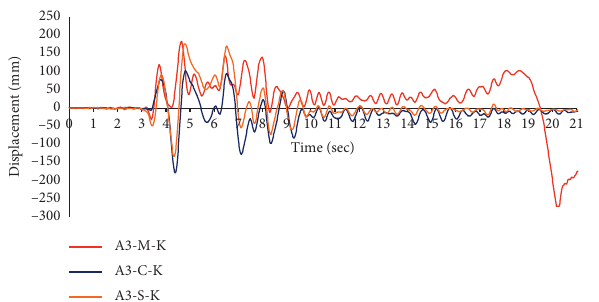
Figure 17: Displacements–time history of the right column of models “A3-M-K, A3-C-K, and